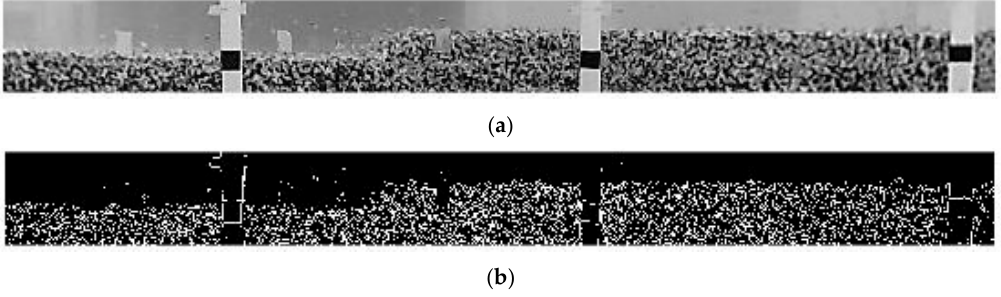
Figure 11. ( a ) A movie frame; ( b ) The image obtained from the Sobel edge-detection method.